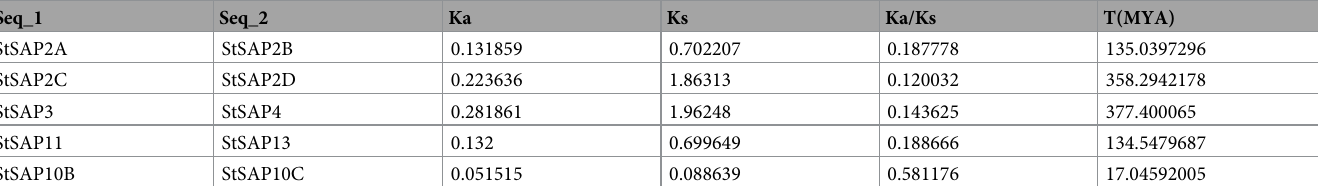
Table 3. Estimated time for segmental duplication and Ka/Ks values for StSAP genes.